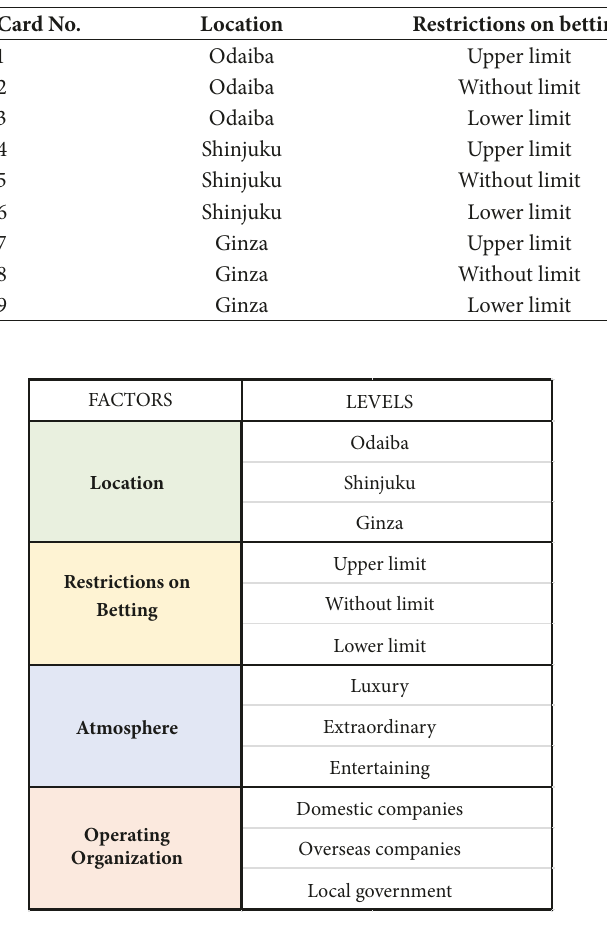
Table 3: The nine conjoint cards.